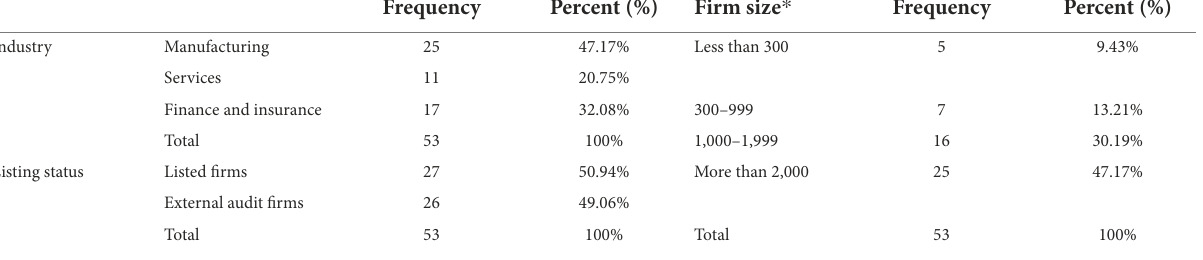
TABLE 1 Data sample characteristics of firms.